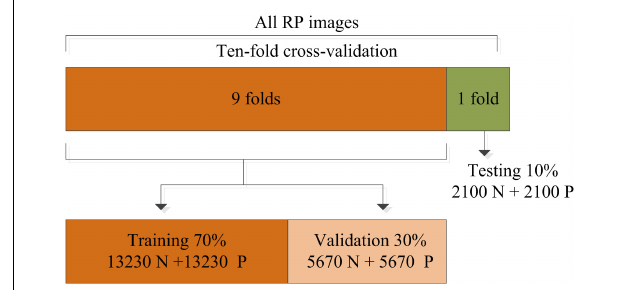
FIGURE 5 | Division of the recurrence plot (RP) image dataset used for training, validation, and testing.